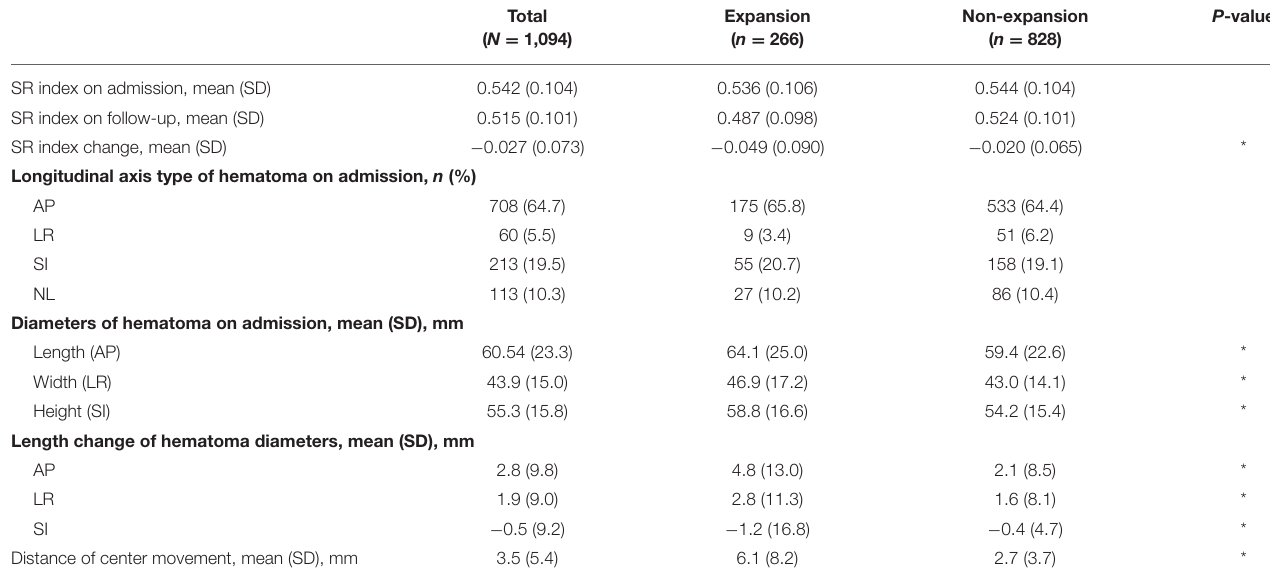
TABLE 2 | Morphological characteristics of hematoma